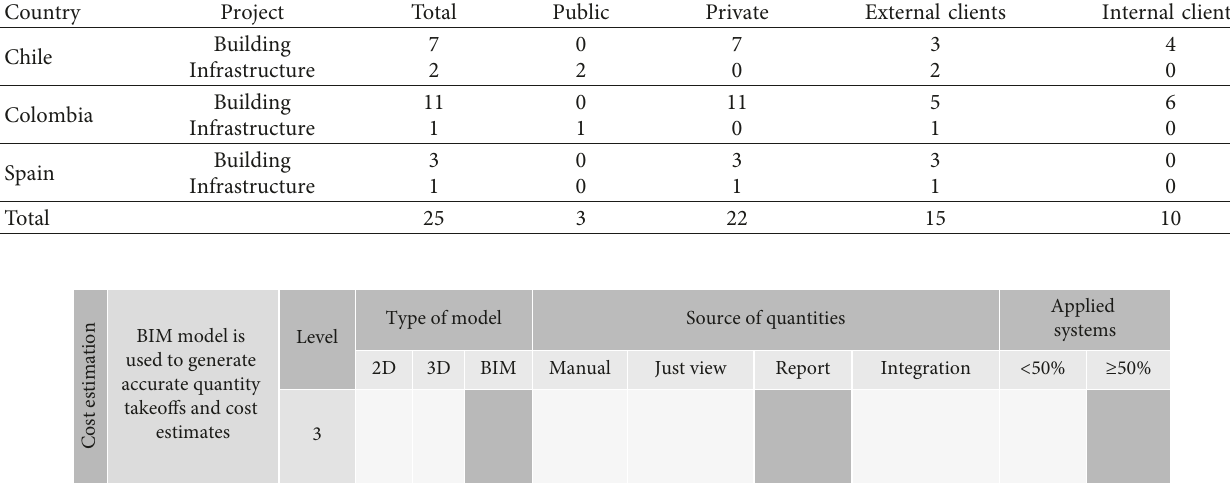
Figure 3: Cost estimation evaluations (example of an assessment). Table 7: Concordance